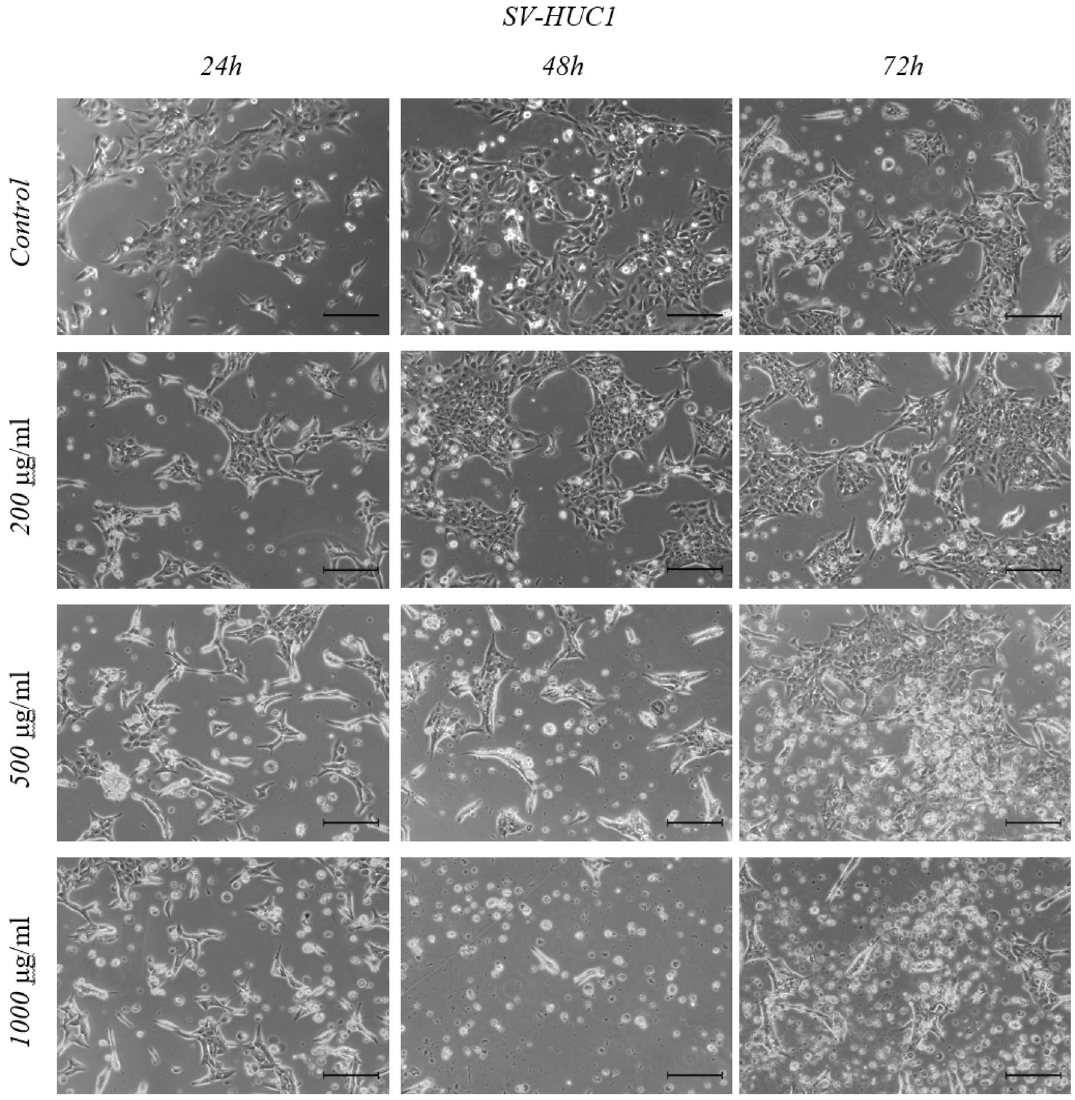
Figure 2. SV-HUC-1 cell morphology after Mumio treatment. Fewer attached cells were observed after 24 h incubation at the highest Mumio concentration. Changes in cell morphology such as cell shrinkage